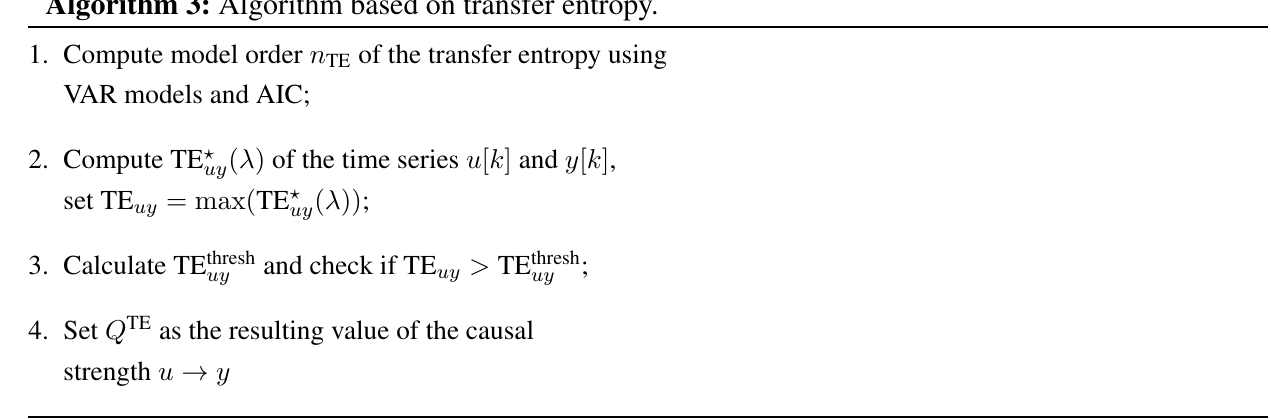
Algorithm 3: Algorithm based on transfer